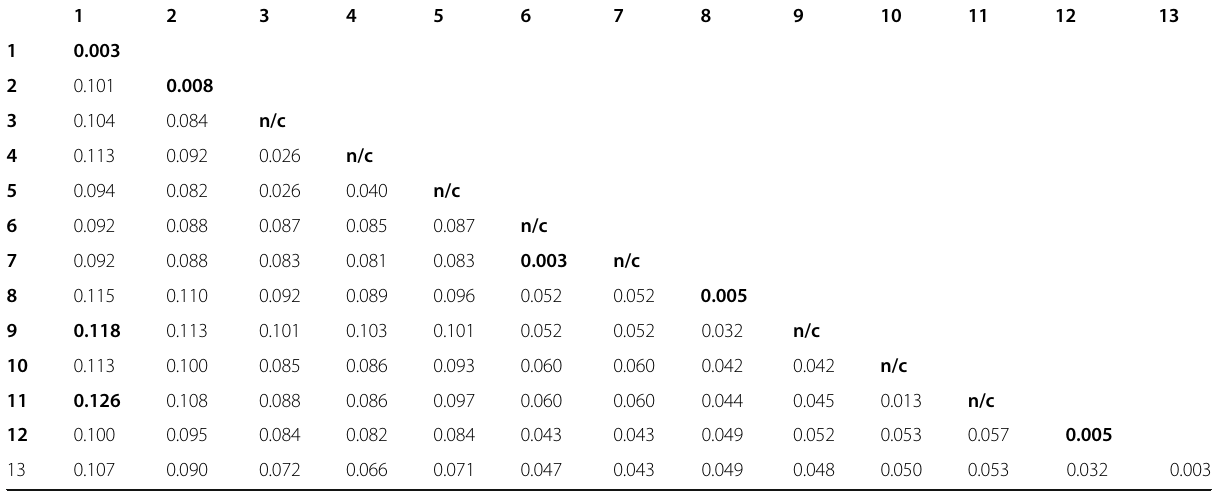
Table 3 Pairwise genetic distance using the K2P distance model between 13 Antilopinae species (below diagonal) and mean genetic distance within species represented with two or more specimens (bold numbers on